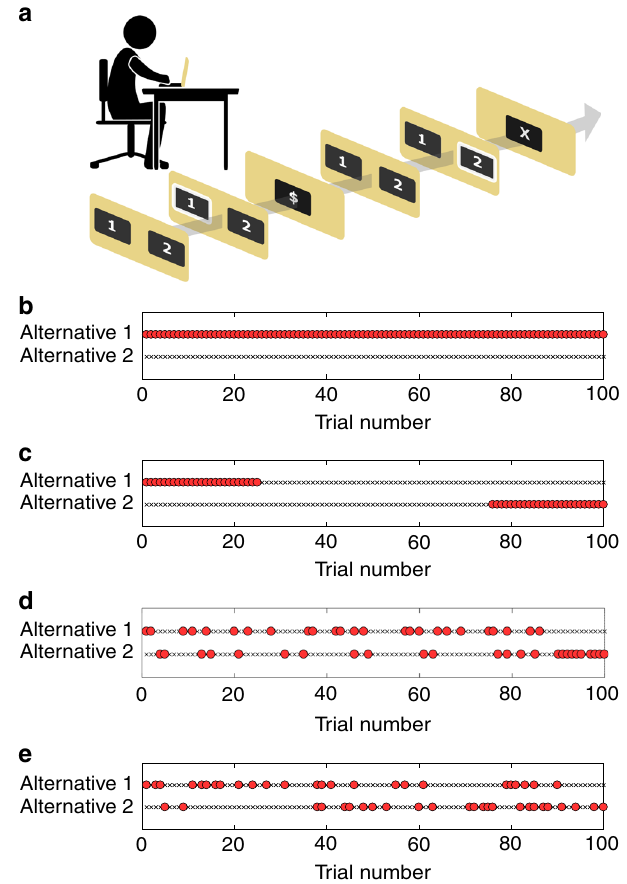
Fig. 1 Choice engineering in a repeated two-alternative forced-choice task. a Experimental task — A reward schedule allocates binary rewards to each of the alternatives in each of the trials. The subject repeatedly chooses between the two alternatives. If the subject chooses a rewarded alternative, then she receives a monetary reward in that trial. In this example, the fi rst choice is “ 1 ” and it yields a reward ($ sign) while the second choice, “ 2 ” , does not yield any reward. No feedback is given about the foregone payoff (the reward that was associated with the alternative that was not chosen). b Based on the Law of Effect, bias in favor of alternative 1 is expected to be maximal if all choices of alternative 1 are associated with a reward (red circles) while choosing alternative 2 is never rewarded (black X). c Choice architecture. If the number of rewards associated with the two alternatives is constrained, a choice- architect may choose to use the primacy heuristic and place all rewards associated with alternative 1 at the beginning of the sequence and those of alternative 2 at its end. d , e A choice engineer can utilize a quantitative model of choice to optimize the reward schedule. d Static schedule optimized for